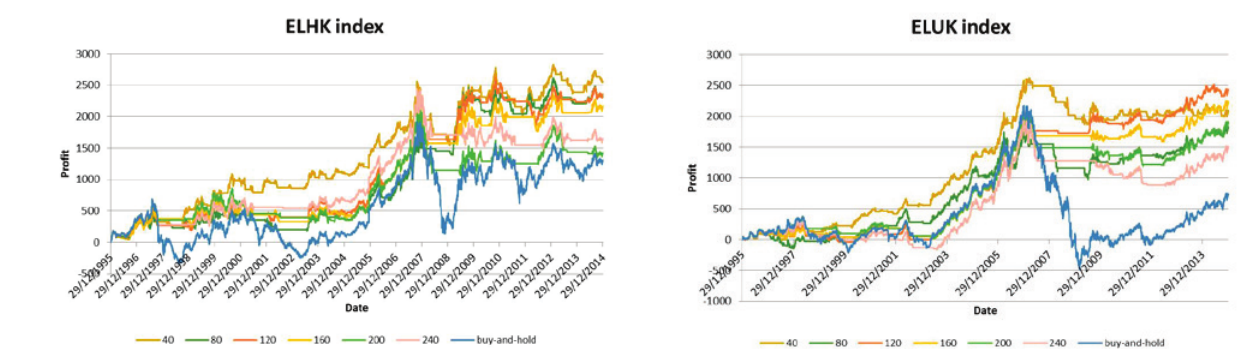
Figure 4. Profits of our strategy and “buy-and-hold” on ELUK index (without transaction costs)